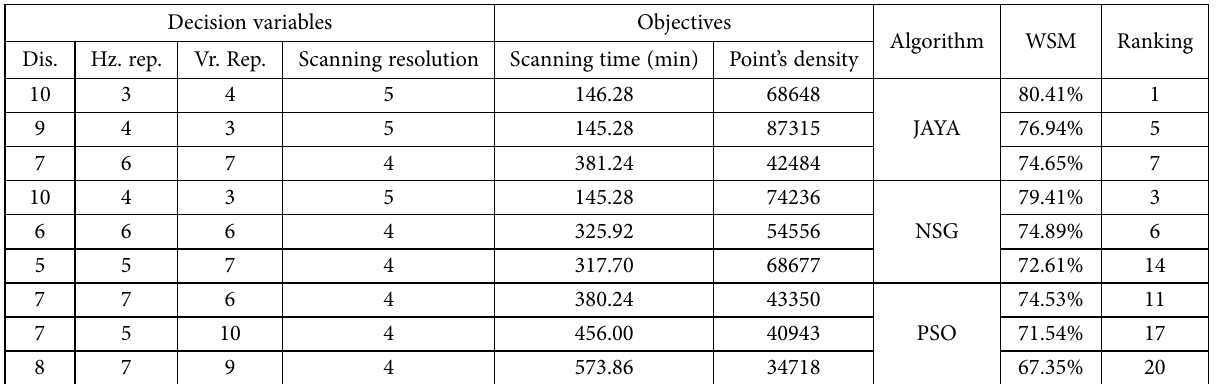
Table 3. The WSM solutions’